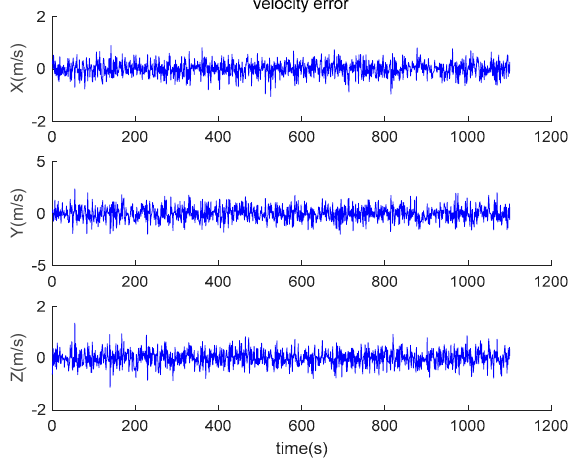
Figure 15. Velocity errors between theoretical trajectory and calculated trajectory.